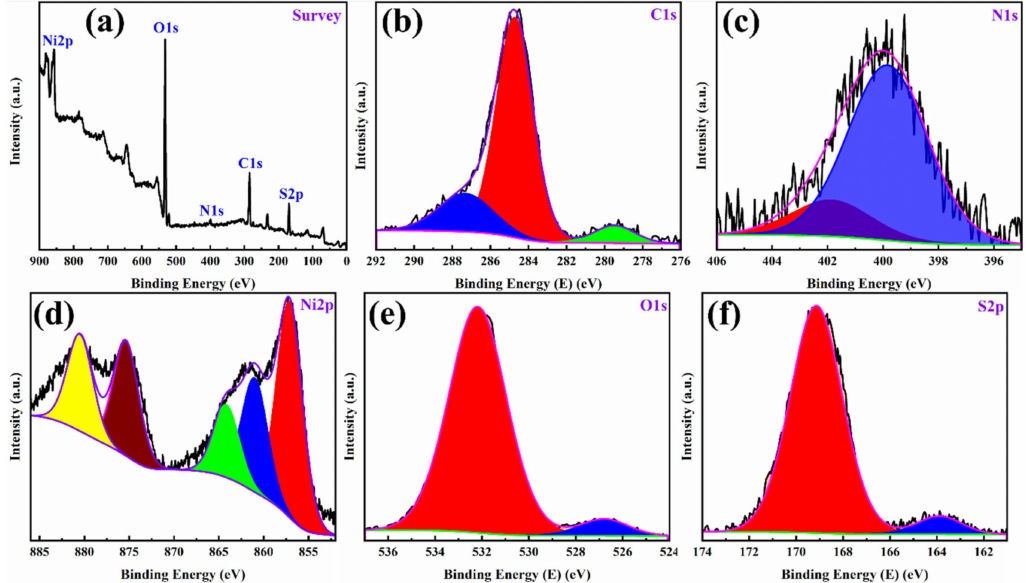
Figure 6. ( a ) XPS survey spectrum of PANI/NF and high resolution deconvoluted XPS spectrum of ( b ) C1s, ( c ) N1s, ( d ) Ni2p, ( e ) O1s, and ( f )